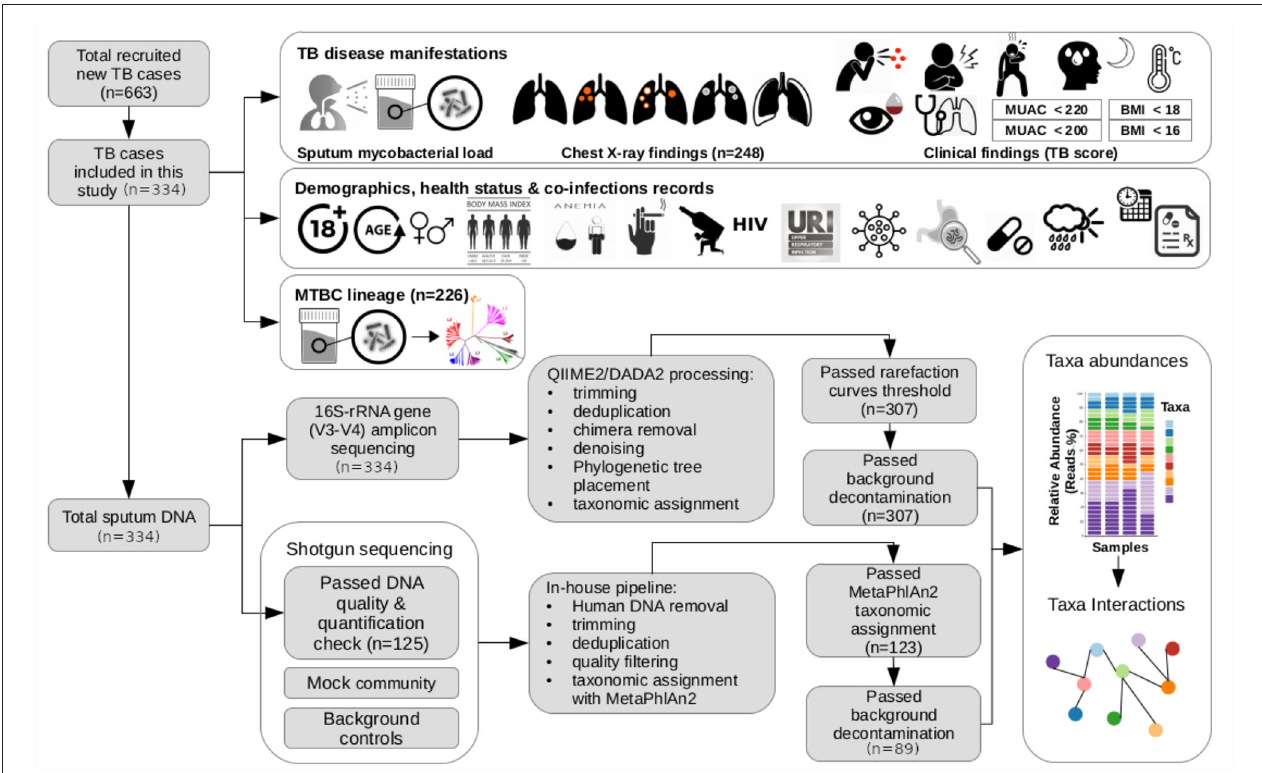
FIGURE 1 | Schematic summary of the study. In this study, we included 334 participants of the newly diagnosed adult TB patients ( ≥ 18 years old) recruited within November 2013 and November 2015 for an ongoing prospective cohort study (TB-DAR). TB-DAR studies the clinical and molecular epidemiology of TB in the Temeke district of Dar es Salaam, Tanzania. Baseline clinical and demographic characteristics were retrieved for each TB patient. Early-morning expectorated sputum samples were collected to characterize the taxonomic microbial composition by targeted 16S-rRNA-gene amplicon sequencing (16S-AS) and whole-metagenome shotgun sequencing (WMS-S). Briefly, the data analysis workflow is shown. We assessed the potential association of the sputum microbial composition with three aspects of TB disease manifestations: (i) mycobacterial load in the sputum; (ii) chest X-rays findings; and (iii) severity of clinical findings, estimated by a TB disease score considering signs and symptoms for TB. As shown in the figure, top right, clinical findings included cough, haemoptysis (i.e., expectoration of blood), chest pain, dyspnoea (i.e., shortness of breath), night sweating, fever, anemic conjuctivae, positive finding at lung auscultation, MUAC < 220mm, MUAC < 200mm, BMI < 18kgm − 2 , and BMI < 16kgm − 2 . BMI, Body Mass Index; MUAC, Mid-Upper Arm Circumference: URI, Upper Respiratory